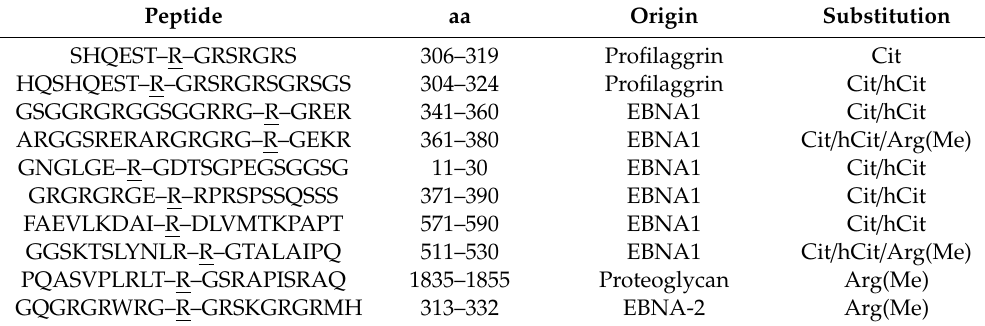
Table 1. Peptides used in the current study. The underscored amino acids represent the substituted amino